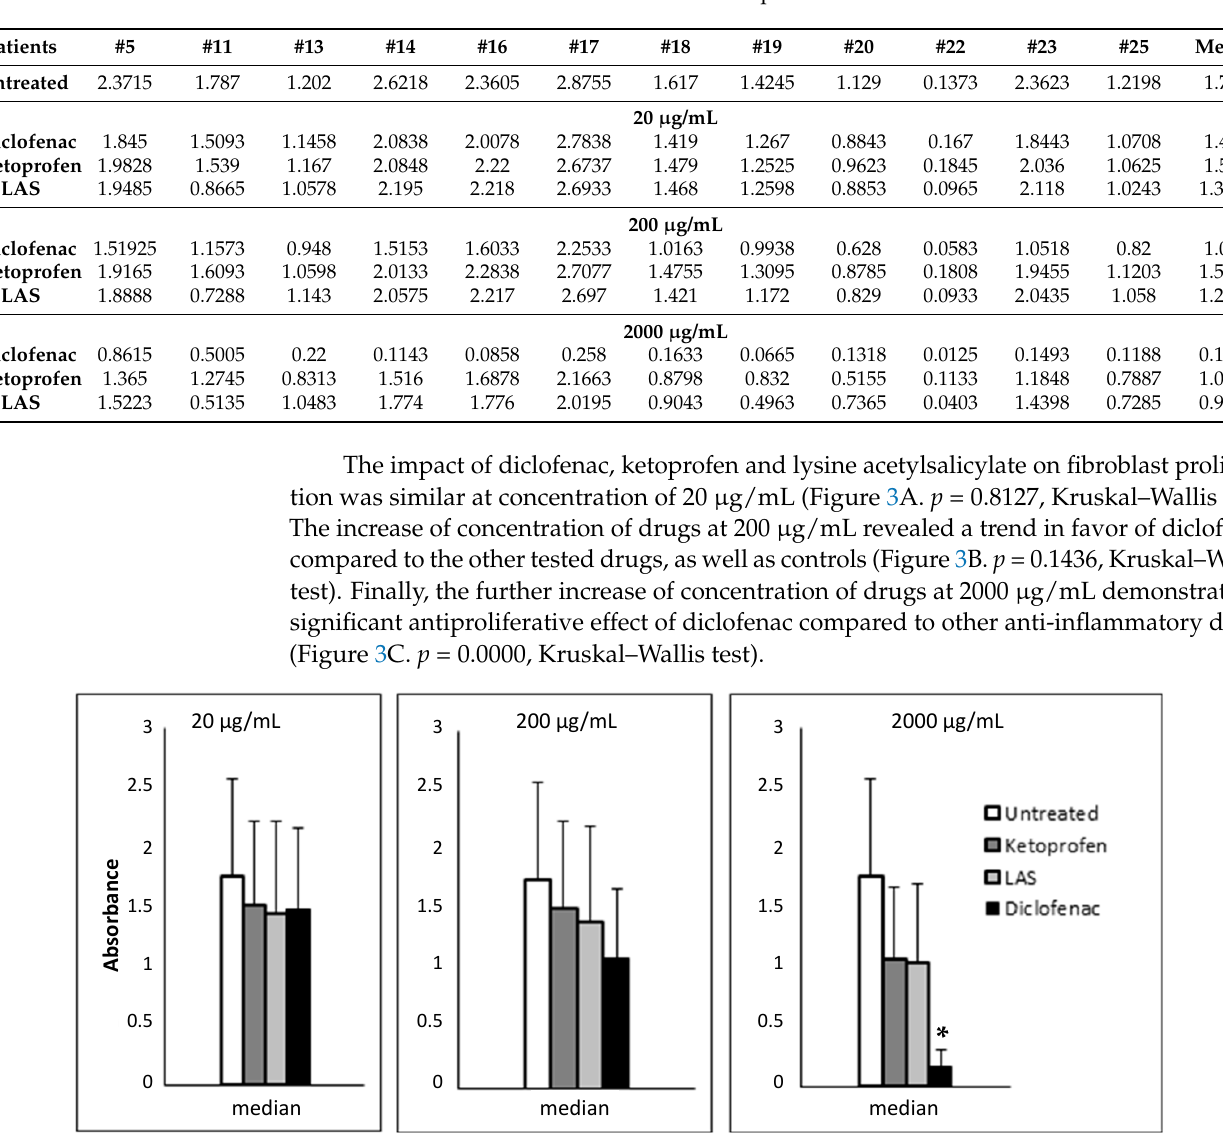
Table 2. Absorbance values of untreated and exposed cells.